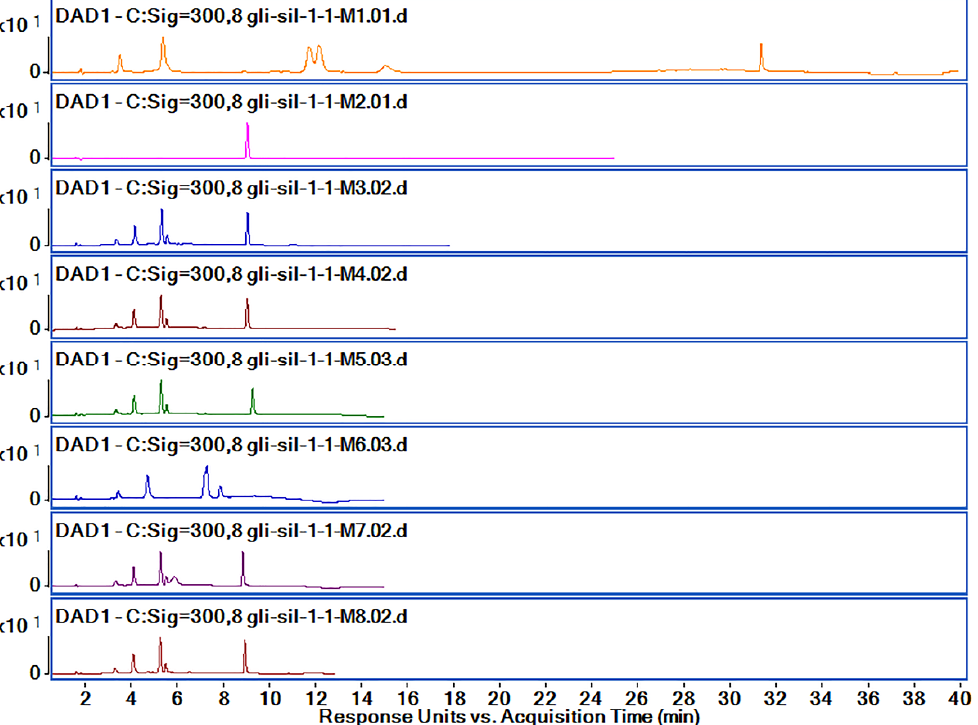
Figure 6. Chromatograms obtained by HPLC-DAD (300 nm) for the active substances’ mixtures using M 1 –M 8 methods.